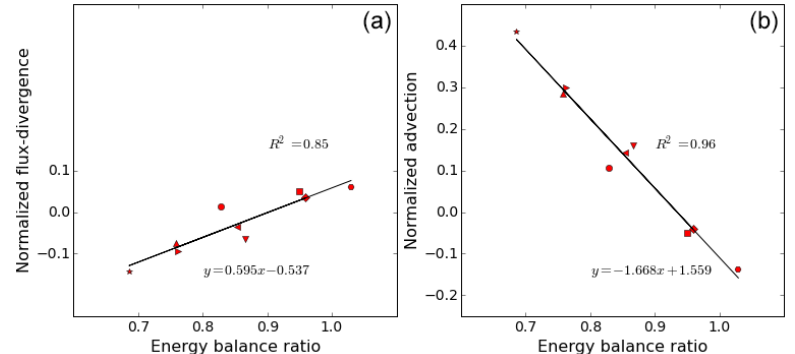
Figure 5. Correlation between flux-divergence and EBR for kilometer scale heterogeneity (a) ; correlation between advection and EBR for kilometer scale heterogeneity (b)